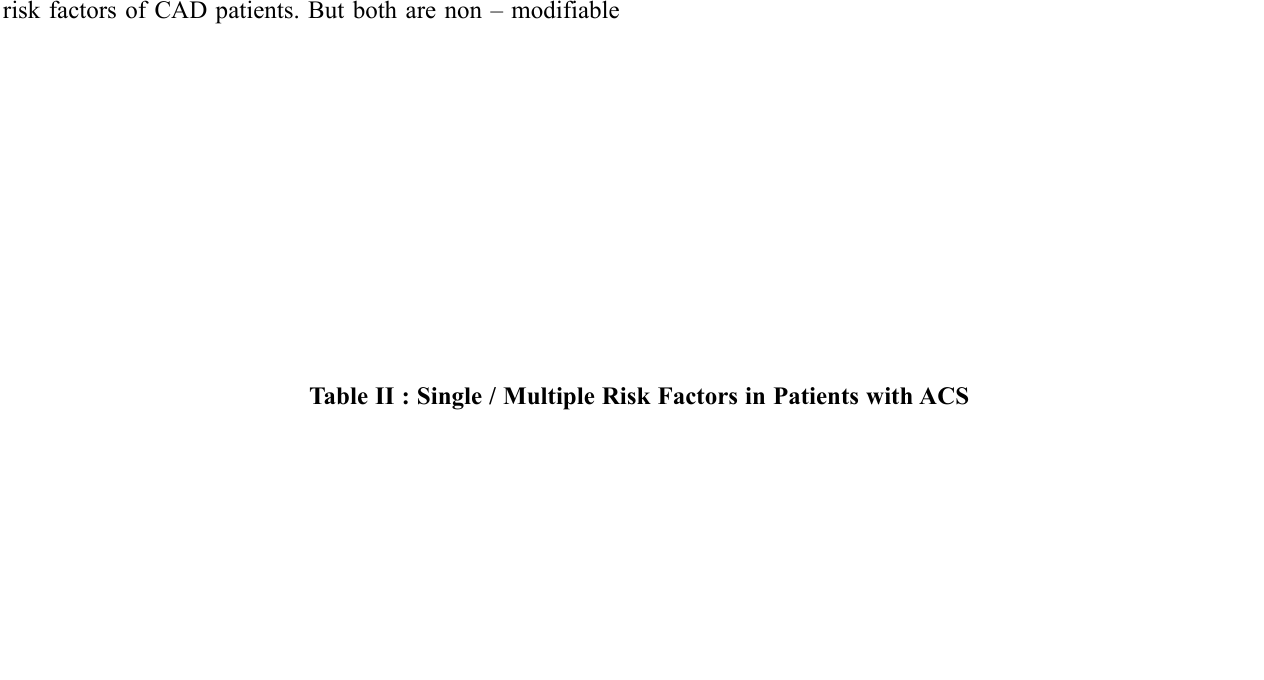
Table II : Single / Multiple Risk Factors in Patients with